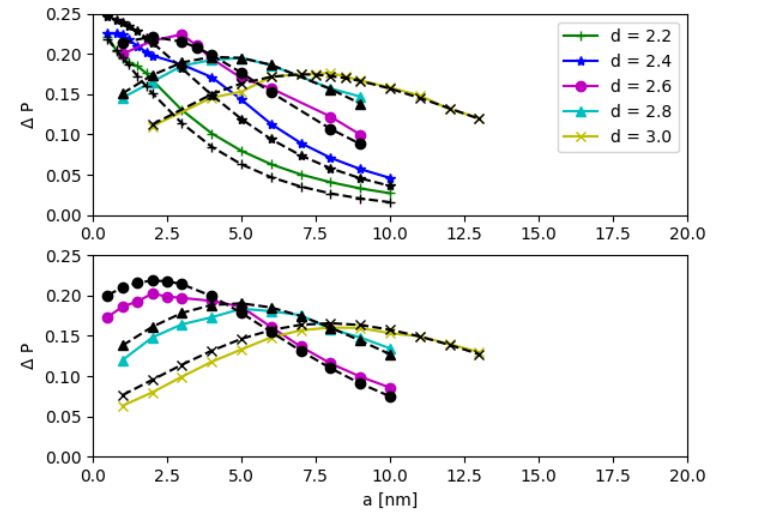
Figure 12. CNOT operation efficiency ∆ P as a function of the inter-DQD distance a , the QD base length b = 2.0 nm and b = 2.2 nm for the top and bottom panels, respectively. The different inter-QD distance d is depicted by different symbols. The black dash lines and other color solid lines are from the matrix and electronic potential models,